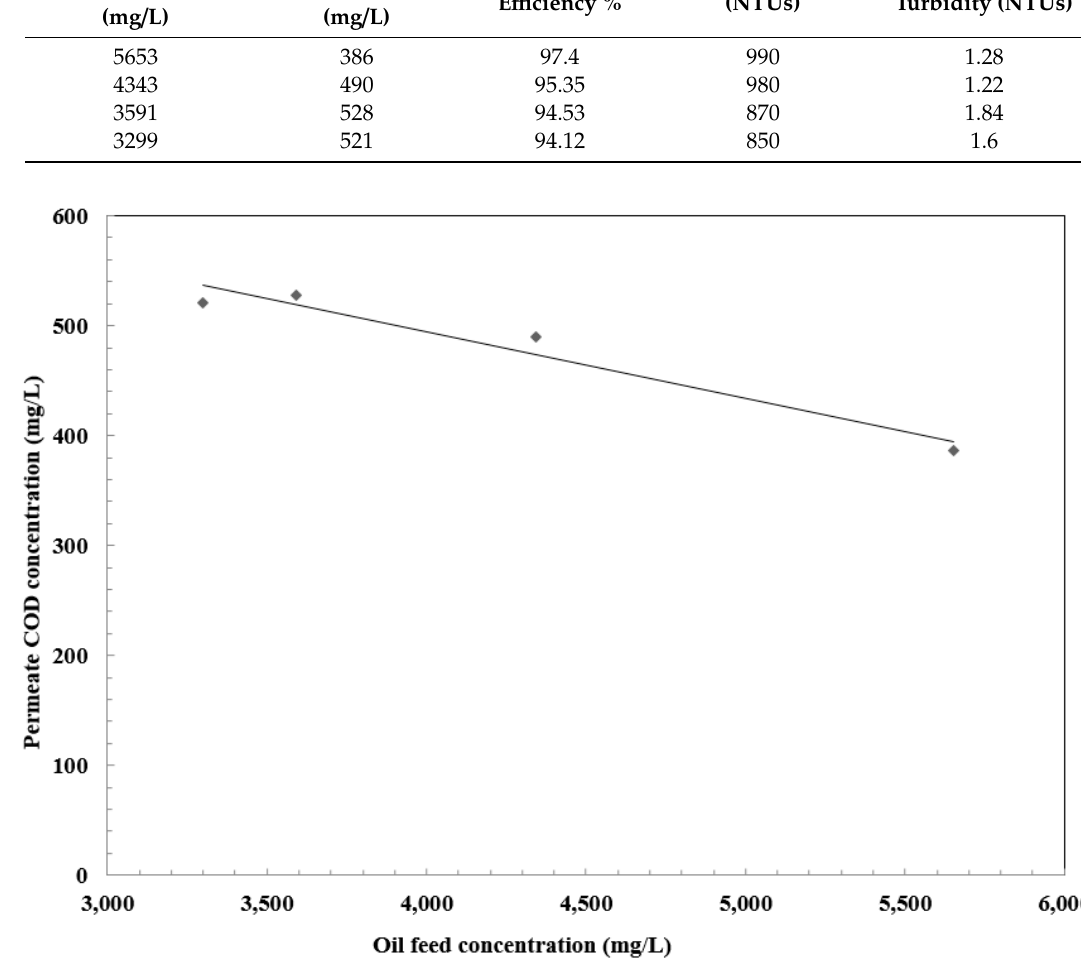
Figure 11. Effect of feed concentration on permeate COD. Figure 11. E ff ect of feed concentration on permeate